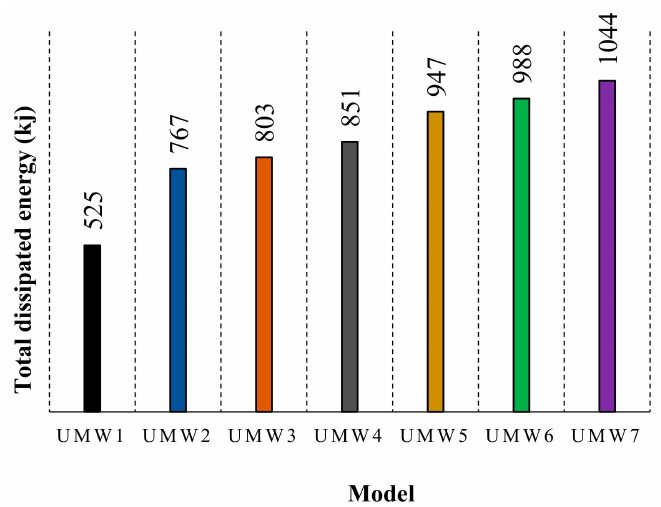
Figure 22. Total energy dissipation of each